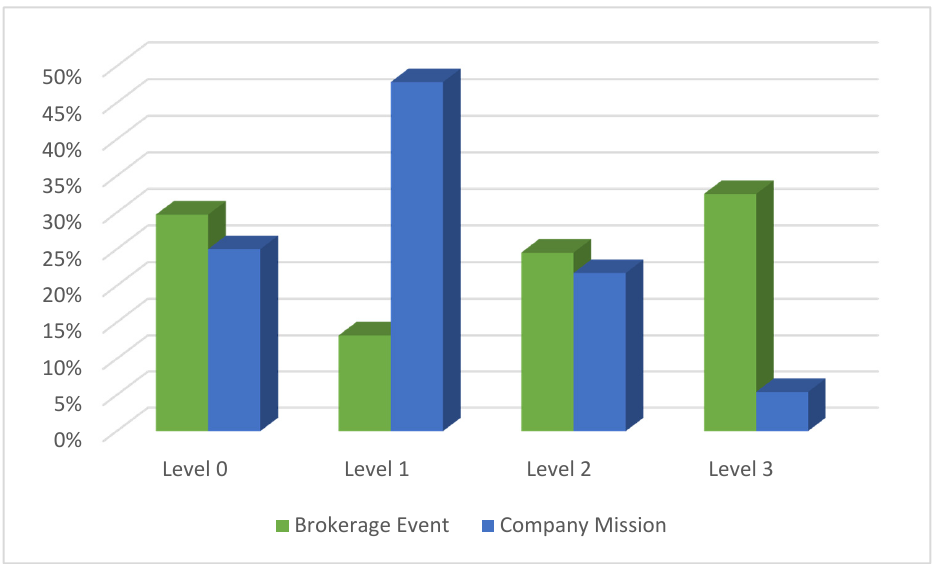
Figure 5. The percentage distribution of the analyzed events across specific levels as per the number of meetings, depending on the type of event. Source: own study.